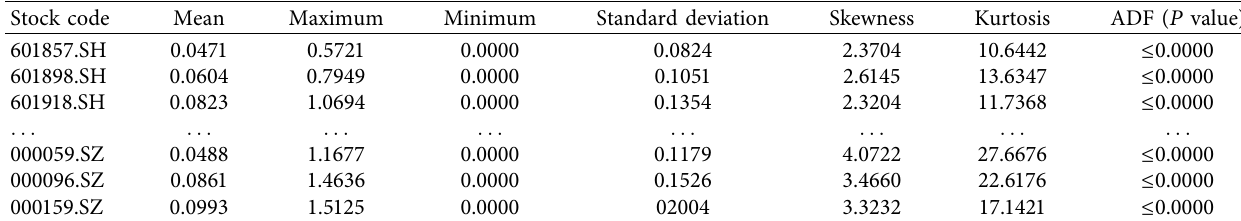
Table 3: Statistical properties of realized jumps for some energy stocks.